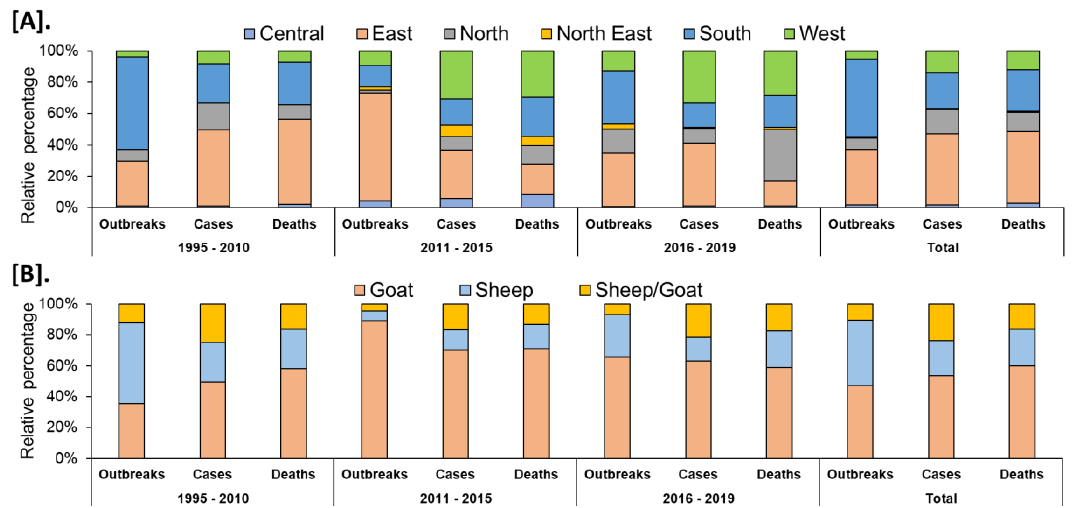
Figure 2. Analysis of cumulative PPR reports in different periods (1995–2019). ( A ). Zone-wise ( B ). Species-wise. Relative percentages of the cumulative outbreaks, cases, and deaths in sheep and goats in different zones of the country during the different analyzed periods. The highest proportion of reported outbreaks and deaths was observed in the South and East zone, respectively.